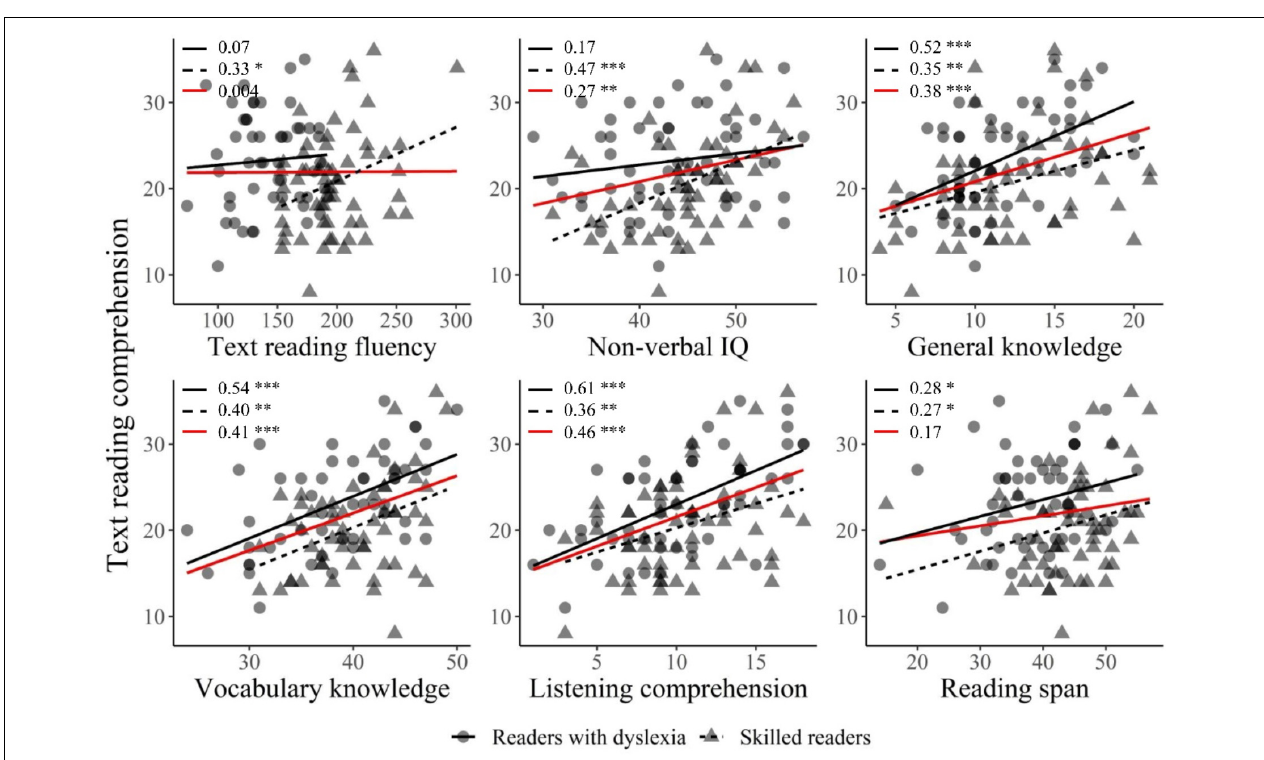
FIGURE 2 | Correlations between text reading comprehension and each of the covariates (i.e., TRF, non-verbal IQ, general knowledge, vocabulary knowledge, listening comprehension, and reading span). Skilled readers are represented by dots, and the corresponding correlation slope is represented by the solid black line. Readers with dyslexia are represented by triangles, and the corresponding correlation slope is represented by the dashed black line. The solid red line represents the correlation slope for the two populations combined. Pearson’s r for each correlation slope is indicated in the top left corner of each plot and asterisks represent the significance level of the p -value ( ∗ p < 0.05, ∗∗ p < 0.01, ∗∗∗ p < 0.001).